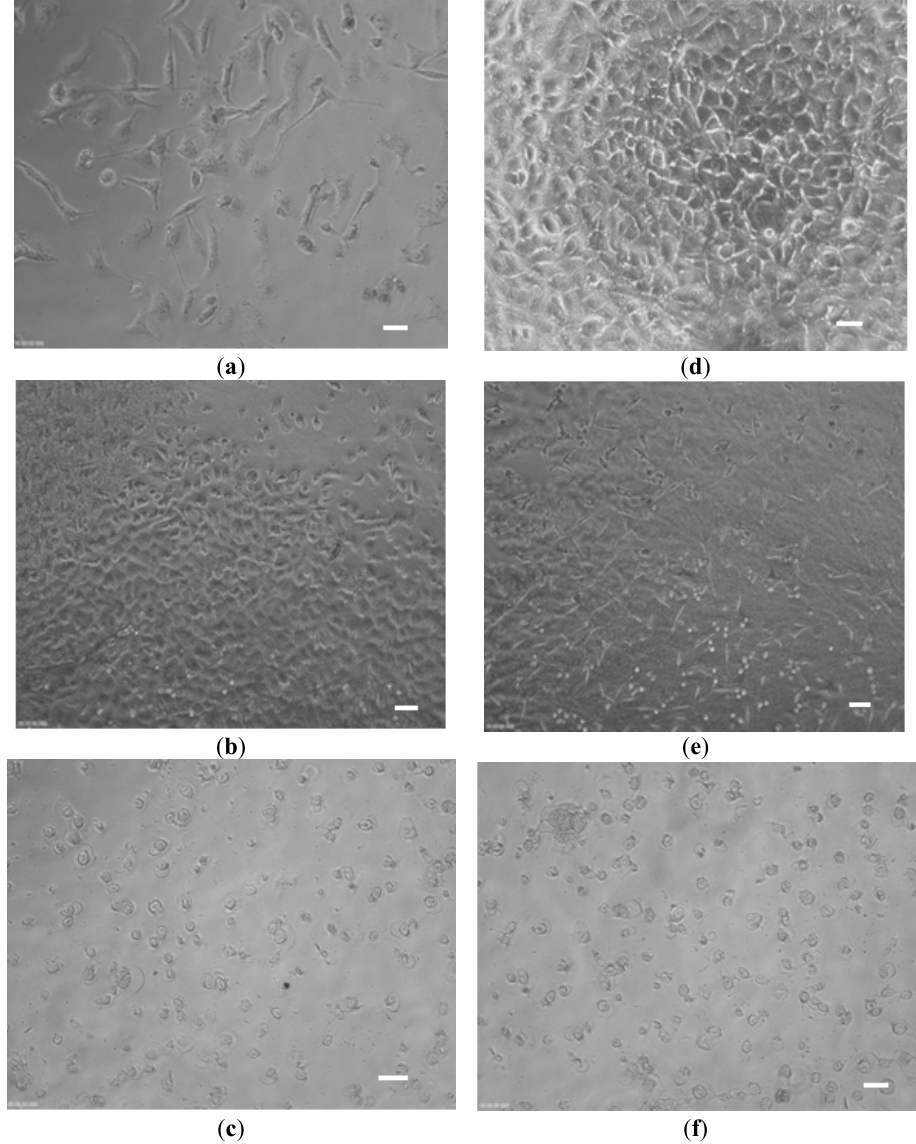
Figure 8. Fibroblast ( a – c ) and MDA breast cancer cells ( d – f ) were cultured on the plates after 24 h incubation; (a,d) uncoated, (b,e) dialyzed keratin coated, and (c,f) diafiltered keratin coated. Scale bar: 5 μ m.